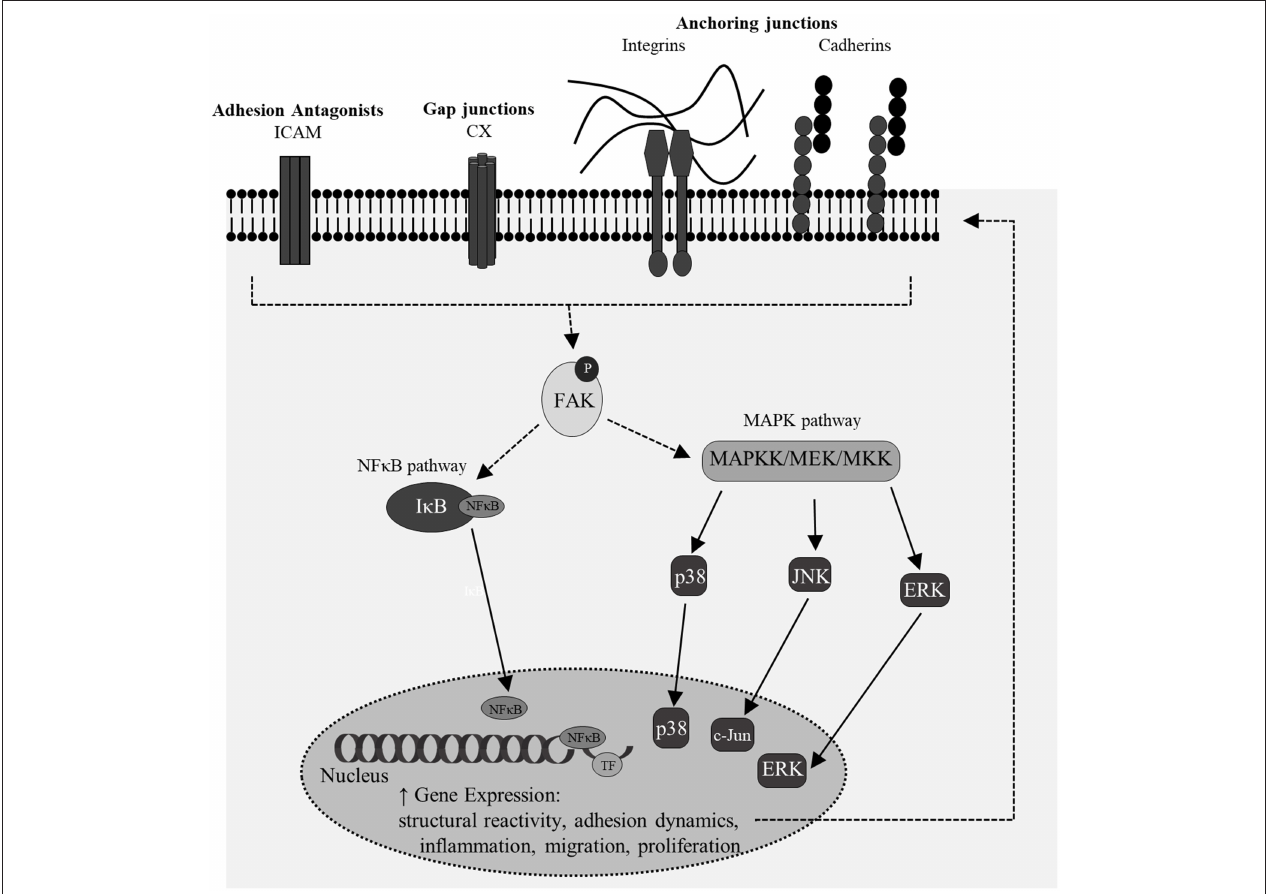
FIGURE 10 | A simplistic overview of potential signaling feedback mechanisms for the regulation of junctional changes and structural reactivity in mechano-activated astrocytes. Multiple of these targets coincided with features of classical reactivity observed in this model of high-rate overpressure